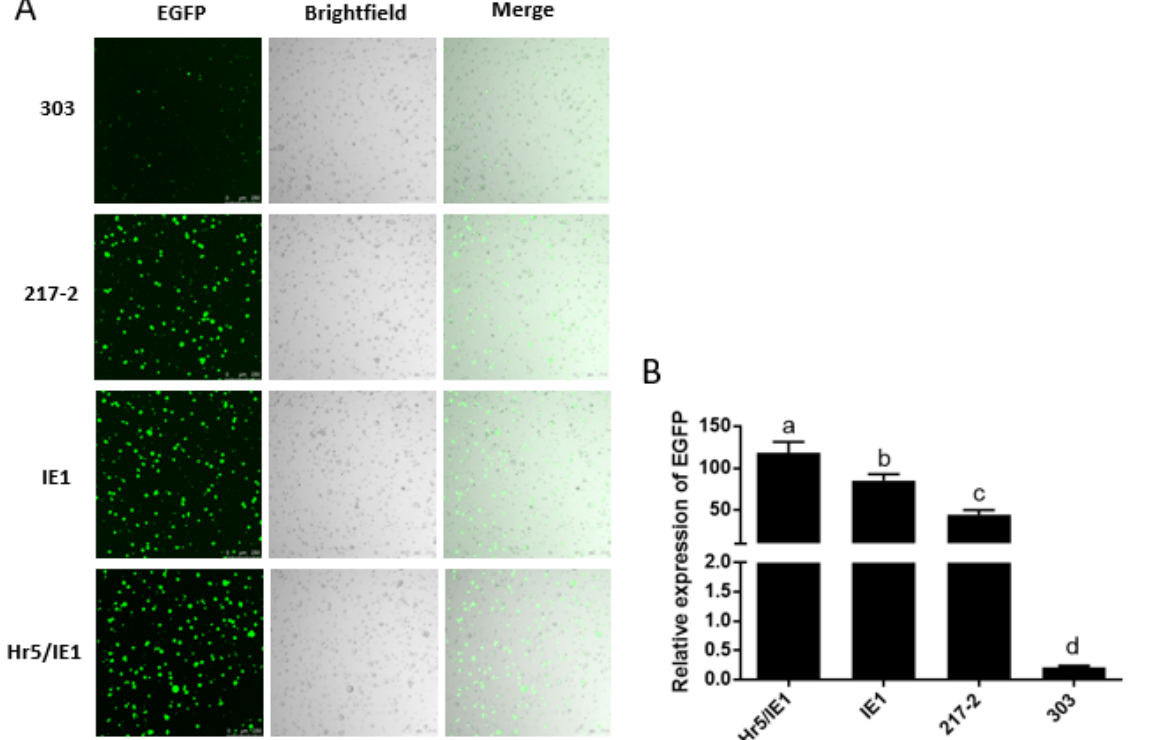
Figure 4. Visualization of the drive efficiency of the 217–2 promoter. ( A ) Fluorescence images of cells with endogenous and exogenous promoters driving EGFP expression. Photographed by laser confocal, exposure time and excitation light intensity are consistent during shooting. ( B ) The relative expression of EGFP driven by different promoters. The significant differences between groups are indicated by lowercase letters (Duncan, p < 0.05).